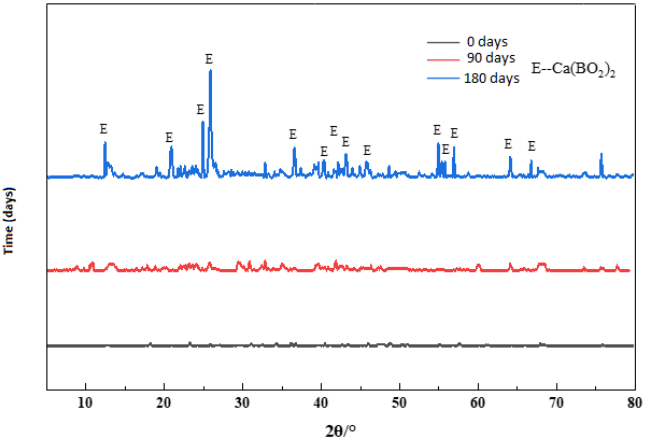
Figure 9. XRD patterns of 70–180,000 ppm at different ages (remove peaks of cement and sand).